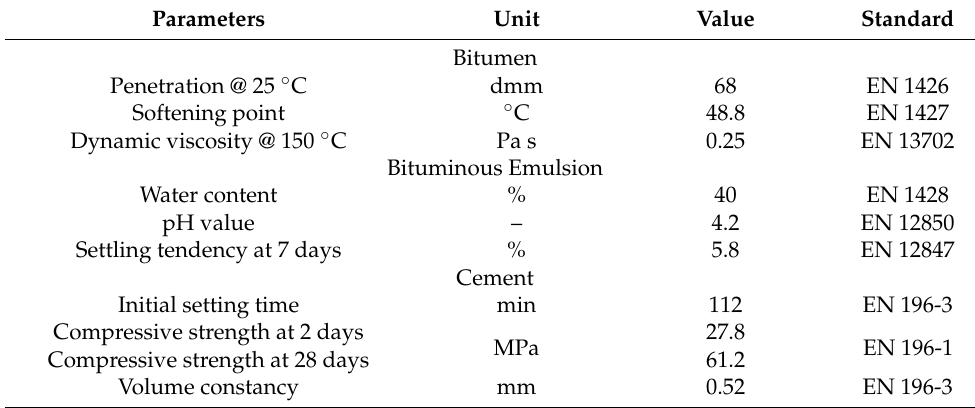
Table 4. Binder properties.